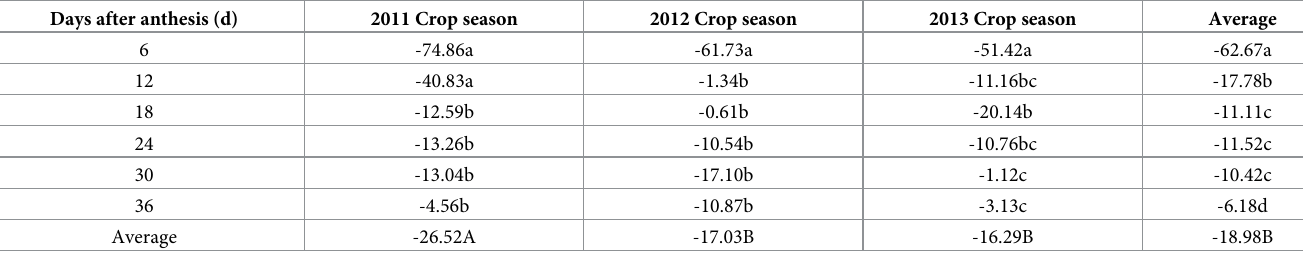
Note: Average line represents the annual average speed difference between grouting stage, and the rest of the column data on behalf of the anthesis within the year after different grain filing stage difference. The different letter means the differences at a = 0.05